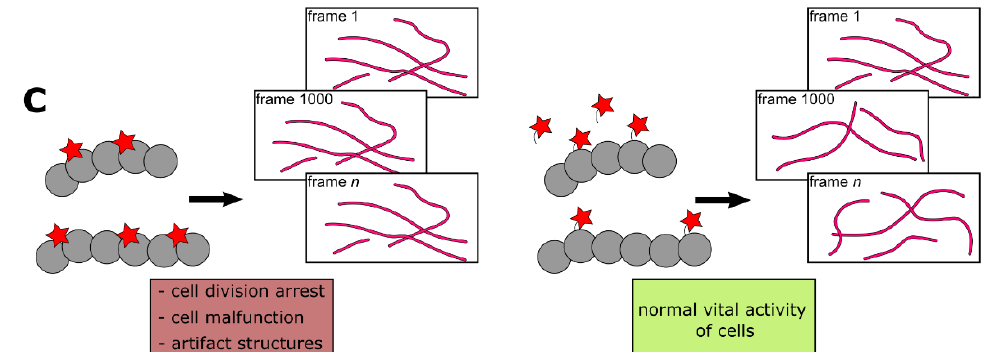
Figure 1. Comparison of permanent (high-affinity or covalent) and exchangeable (transient) labeling. ( A ) Permanent labels are constantly exposed to light irradiation and inevitably photobleached. Therefore, the fluorescent signal deteriorates, making prolonged imaging more complicated. In contrast, the continuous exchange of low-affinity labels with undamaged ones from cytosol or medium increases the apparent photostability of labeling. Red stars denote fluorescent labels, pink stars denote photobleached labels. ( B ) High-affinity labels already bound to target structures, due to their large size, can sterically interfere with the binding of other label molecules. Alternatively, frame-by-frame accumulation of low-affinity labels’ positions followed by frames merging increases effective labeling density. ( C ) Bulky labels, continuously bound to target structures, may affect the dynamics and functioning of the latter. In addition, some labels, such as fluorescently labeled taxol or fluorescent proteins could drastically disturb cell activity. However, in the case of low-affinity labeling, target molecules remain untagged most of the time and therefore their functioning is less hindered.